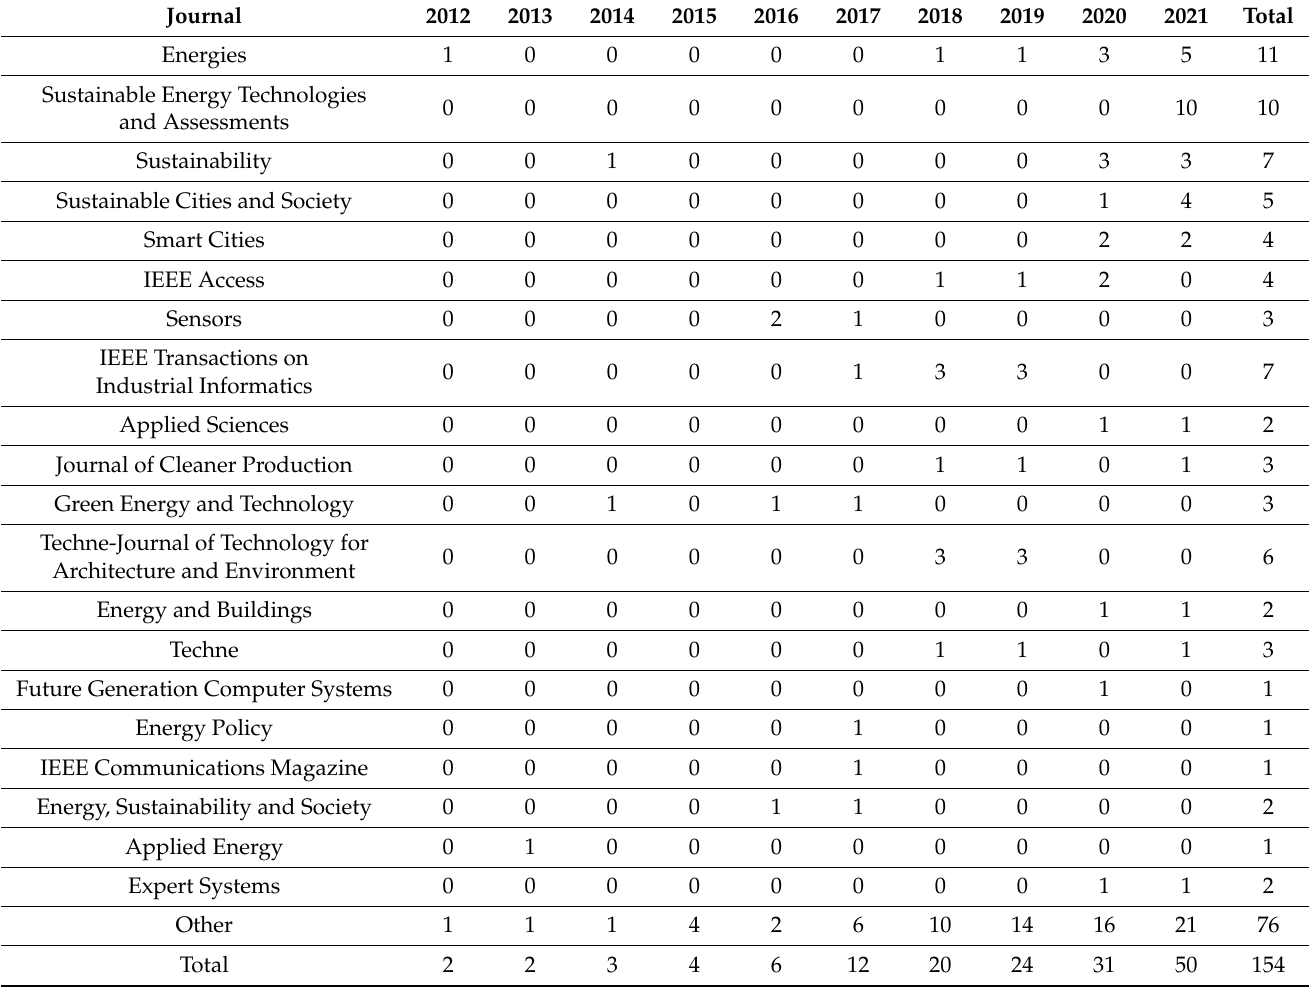
Table 3. Distribution of publications by journals and